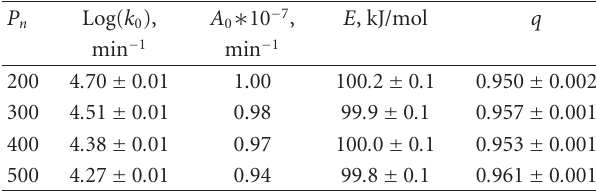
Table 2: Estimations of the Avrami equation parameters for arrays with the initial PDI equal 2 at isothermal depolymerization.